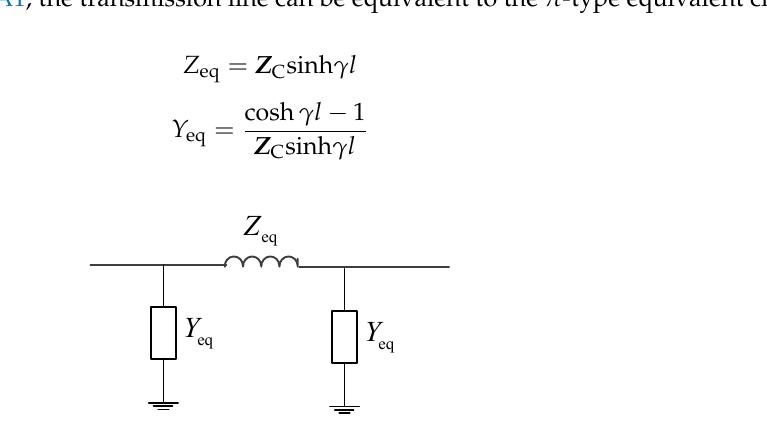
Figure A1. π -type equivalent circuit of the transmission line.